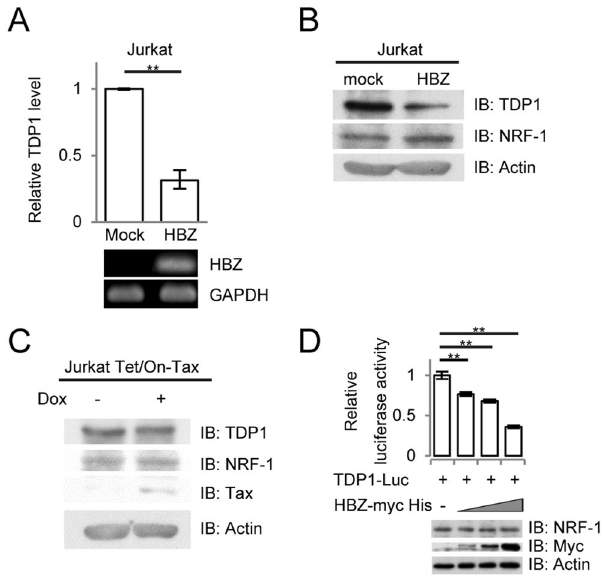
Figure 4. Functional analysis of the effect of the HBZ gene on the expression level of TDP1. ( A ) Comparison of TDP1 mRNA transcription in the Jurkat T cells and the Jurkat-HBZ cells by real-time PCR. Data shown are the mean ± SD ( n = 3). Expression of the HBZ gene in the Jurkat-HBZ cells was analyzed by RT-PCR. ( B ) Comparison of TDP1, NRF-1, and actin expression in the Jurkat T cells and the Jurkat-HBZ cells by immunoblotting. ( C ) Jurkat Tet/On-Tax cells were treated with doxycycline for 36 h. Expressions of TDP1, NRF-1, Tax, and actin are shown by immunoblotting. ( D ) Effects of HBZ on TDP1 -promoter activity. 0.2 µ g of TDP1-Luc ( − 126/ + 193) was transfected into HEK293T cells with or without vectors expressing HBZ (0.05, 0.1, or 0.2 µ g). Relative luciferase activity was calculated by comparison with the basal-luciferase activity of TDP1- Luc. Data shown are mean ± SD ( n =